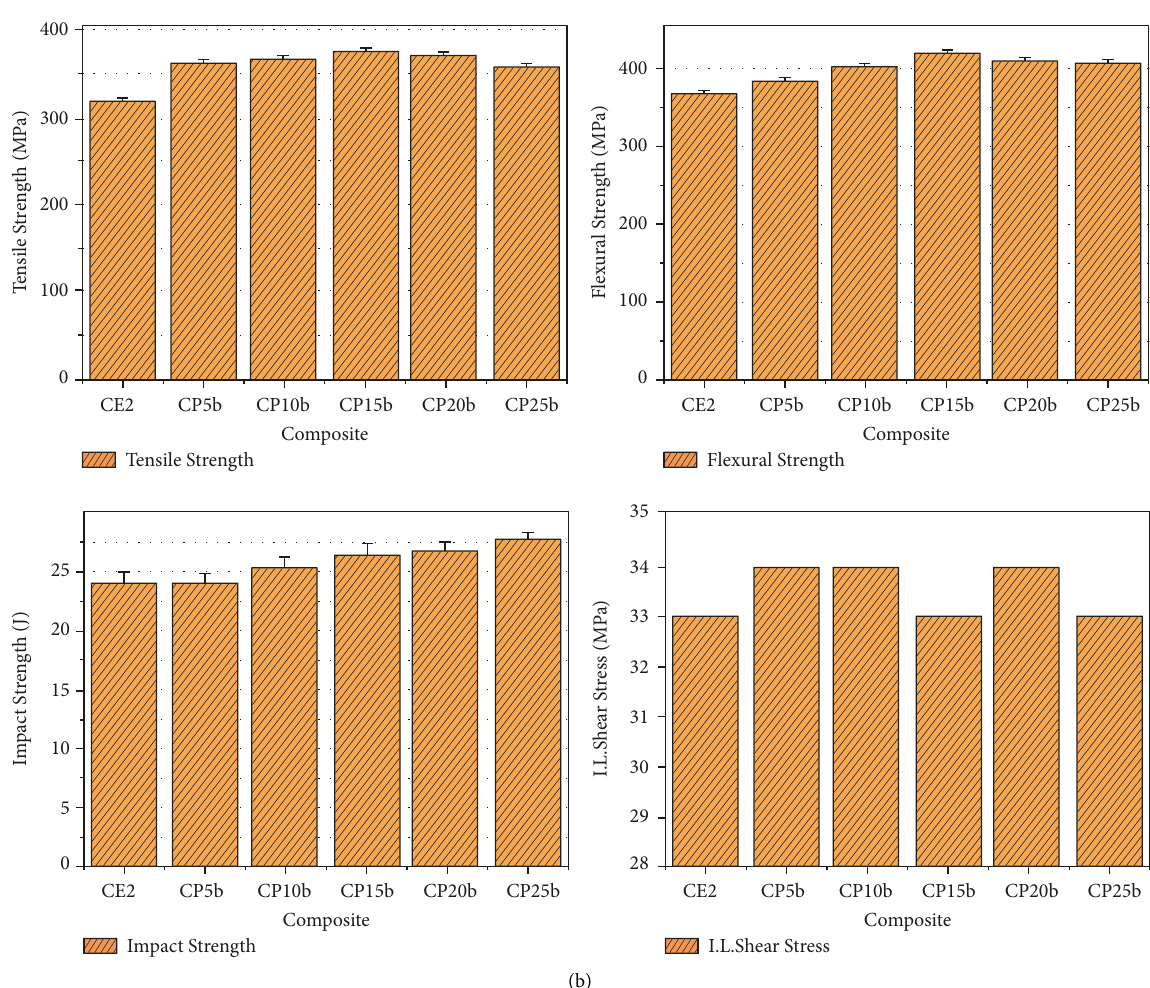
Figure 1: Mechanical properties (tensile, flexural, impact, and interlaminar shear strength) of composite (a) carbon fibre 15 % wt ratio with different pebble weight ratios and (b) carbon fibre 20 % wt ratio with different pebble weight